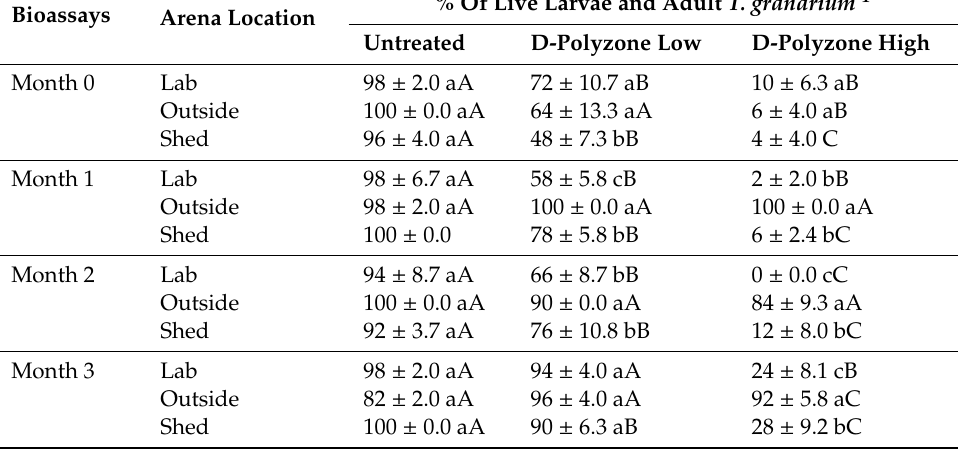
Table 5. Percentage of live larvae plus adult T. granarium (means ± SE) emerging from larvae exposed on untreated arenas or arenas treated with low and high rates of deltamethrin Polyzone ® , 30 days after introduction of larvae. Arenas were held either in the laboratory, in an outside area, or inside a shed.